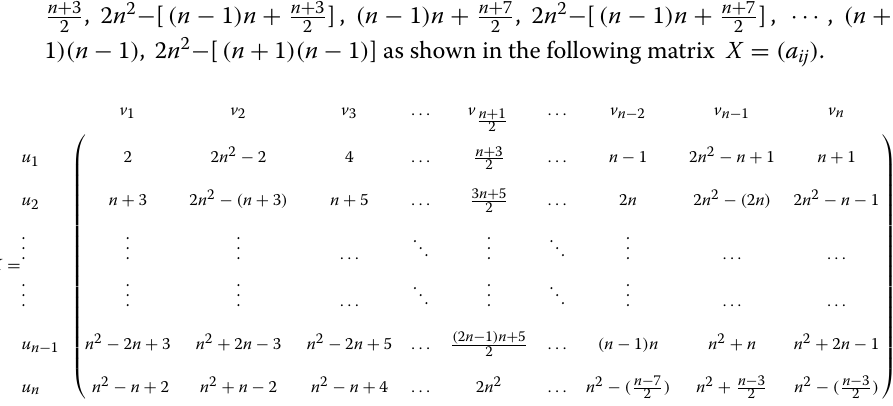
The algorithm for the matrix X = ( a ij ) of the graph K n , n when n ≡ 1 ( mod4 ) is shown